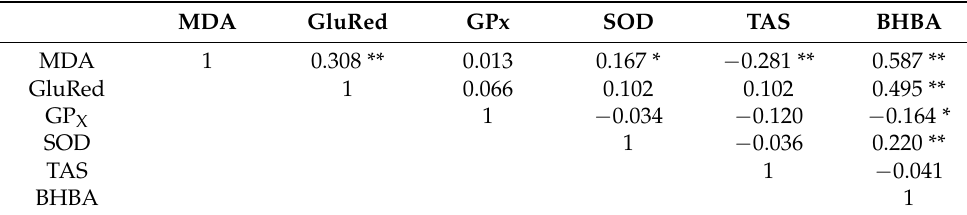
Table 2. Pearson correlations between BHBA and markers of oxidative stress. MDA GluRed GPx SOD TAS BHBA